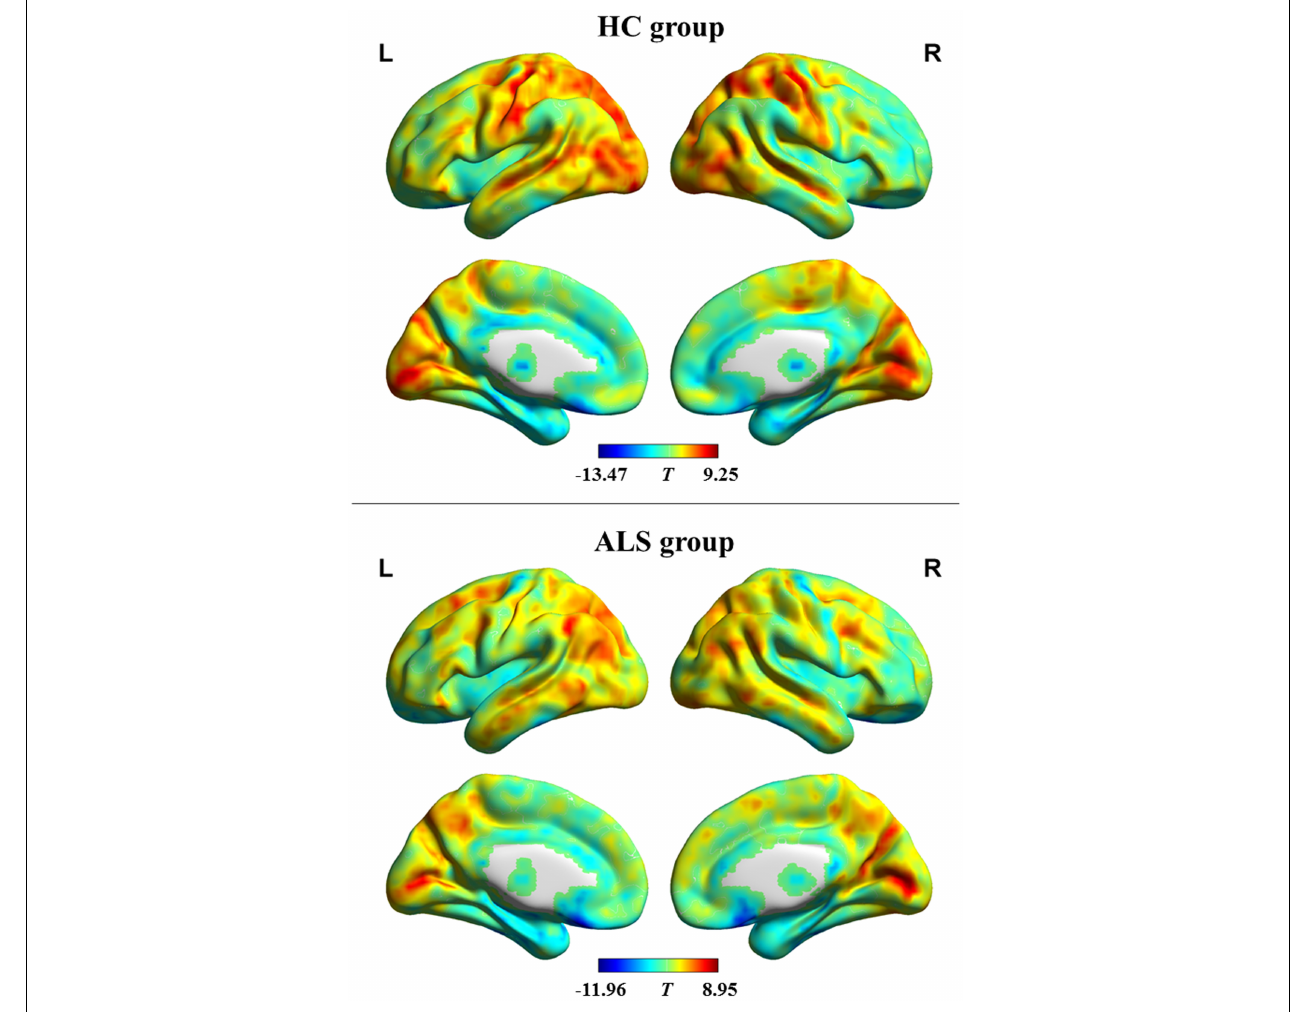
FIGURE 1 | dFCD variability patterns within each group. The brain maps of the T- values indicate the results of one-sample t- testing of dFCD variability. High and low dFCD variability is represented by red and blue color, respectively. ALS, amyotrophic lateral sclerosis; HC, healthy control; L, left; R, right.